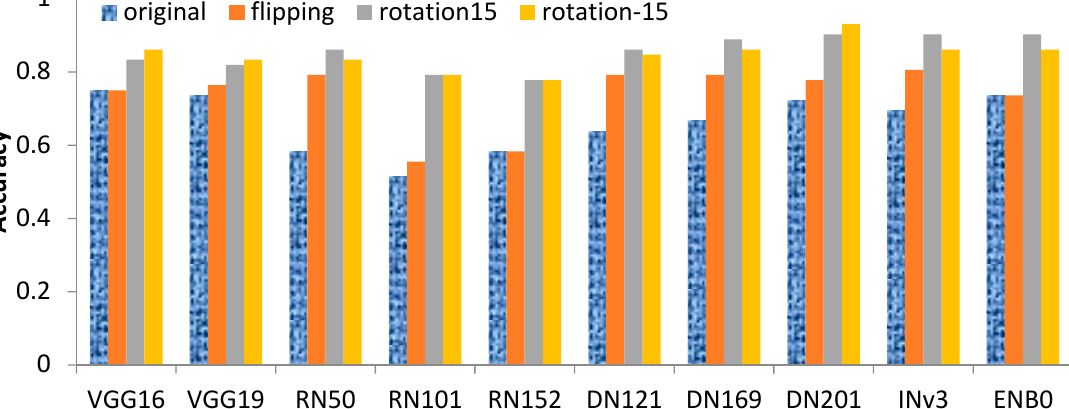
Figure 9. Accuracies of different models with different data augmentations.